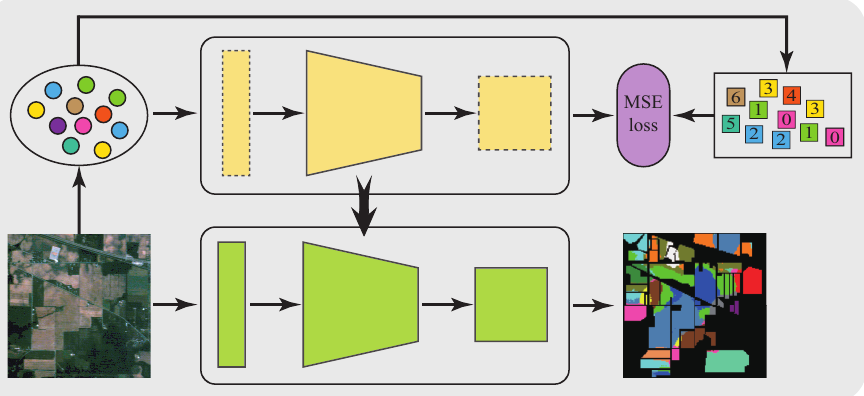
Figure 3. Schematic of fast adaption to target HSIs. The whole model containing the inherited feature extraction module and two other initialized modules is first trained on a few labeled samples to quickly adapt to the new hyperspectral domain. Then, the trained model performs label prediction on the target